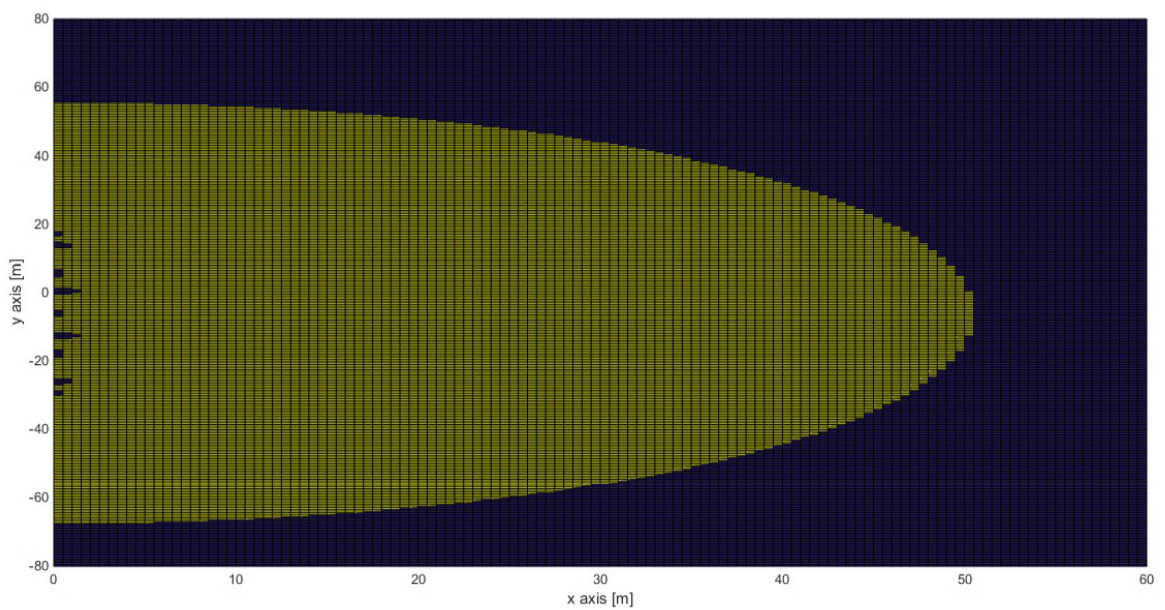
Figure 27. Area of electric field strength, with values higher (yellow) and lower (blue) than the limit of 1.25 V/m for method “C” of linear current source, for an electrode station of 6 linear frames in a row with d frames = 6.50 m; each frame consists of 13 electrodes of active length L = 2.13 m, D el = 0.50 m, ρ w = 0.25 Ω · m, θ = 248 ◦ (area of Korakia), J full_load_steady = 22 A/m 2 (steady state and operation of 5 frames, except no. 6).